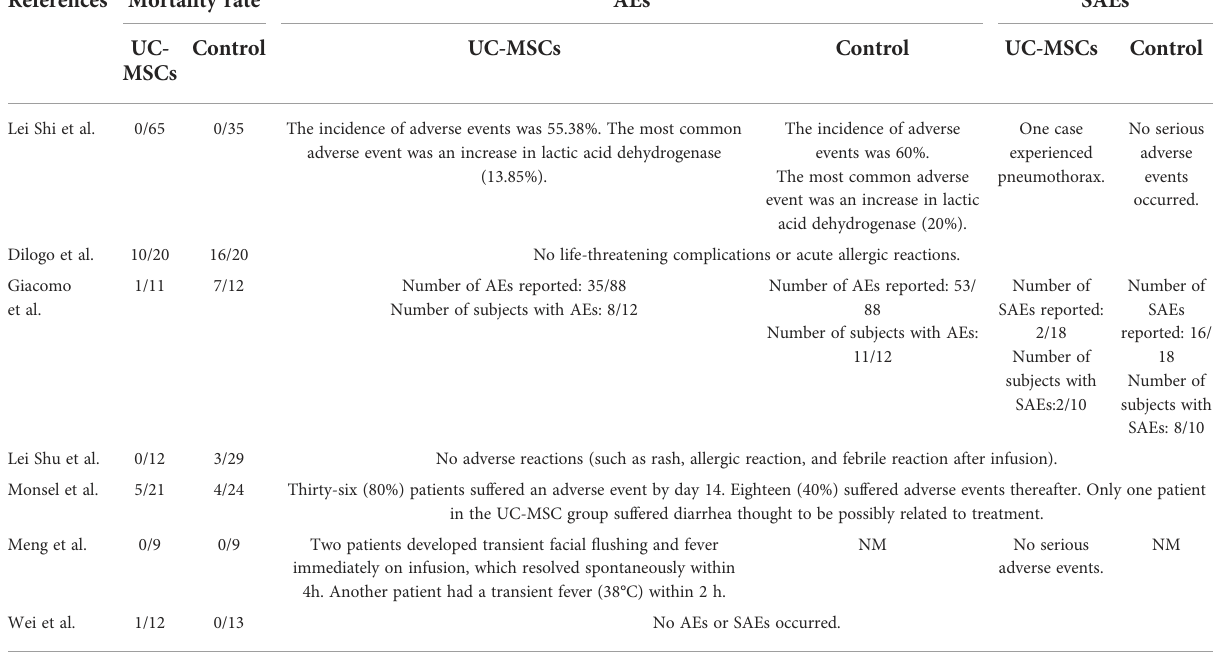
TABLE 4 Primary outcomes.